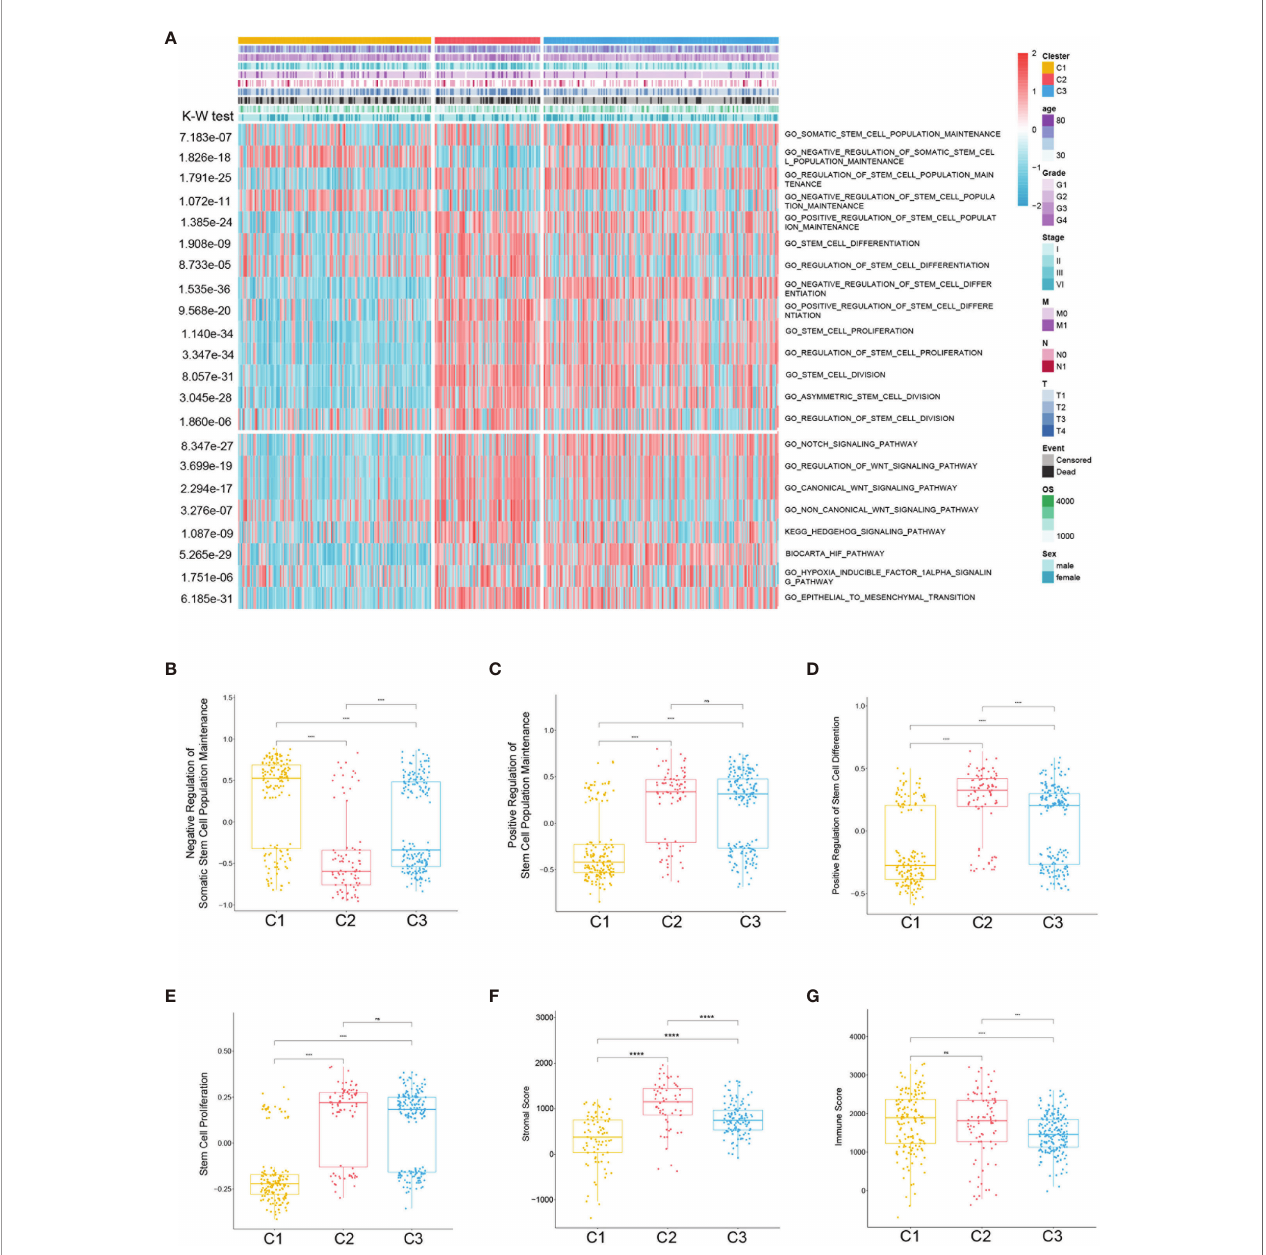
FIGURE 3 | Association between the stem cell-associated signatures and the clear cell renal cell carcinoma (ccRCC) subclasses. (A) Heatmap of the speci fi c stem cell-associated signatures. (B – E) Box plot of the signature scores for the stem cell-associated signatures distinguished by different subclasses. Box plot of the stromal (F) and immune (G) scores from estimates of the three subclasses. The p -values are labeled above each box plot with asterisks . ns , no signi fi cance. *** p < 0.001, **** p <